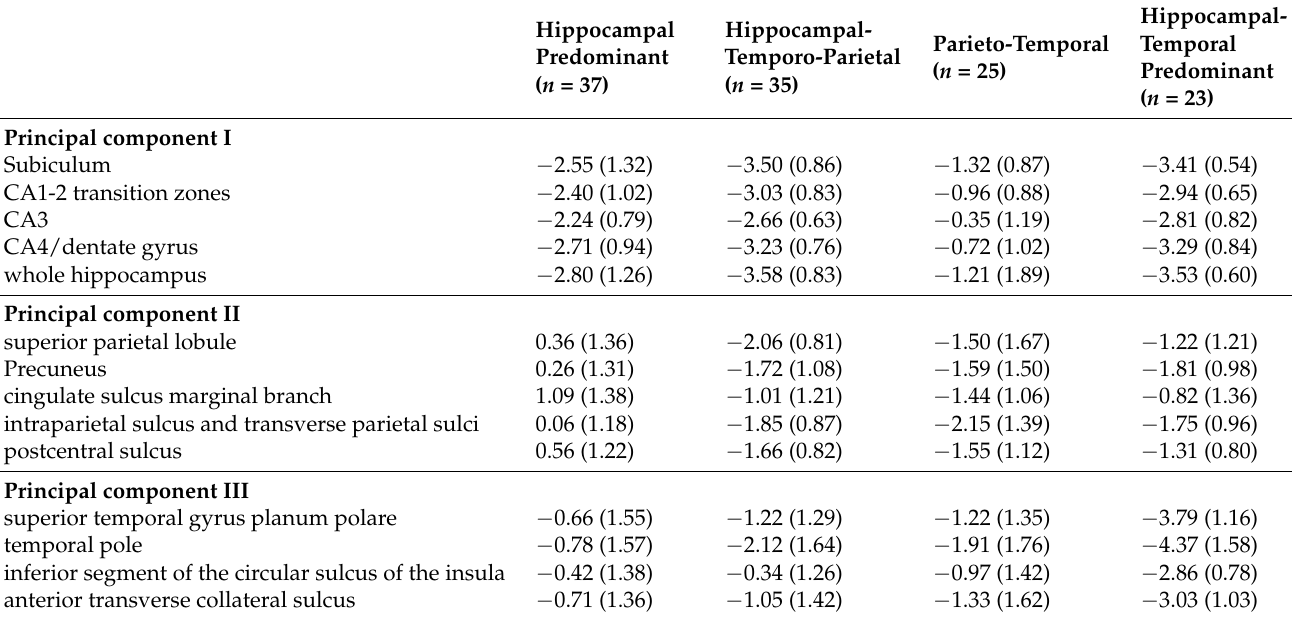
Table 1. Mean z-scores of brain regions identified by the principal component analysis.